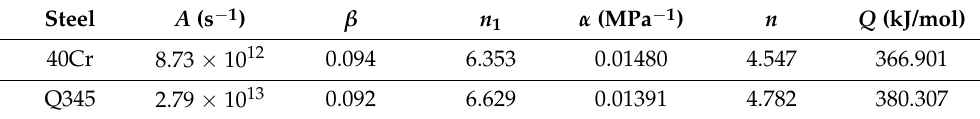
Table 3. Material constants of 40Cr and Q345B in the hyperbolic-sine equation.